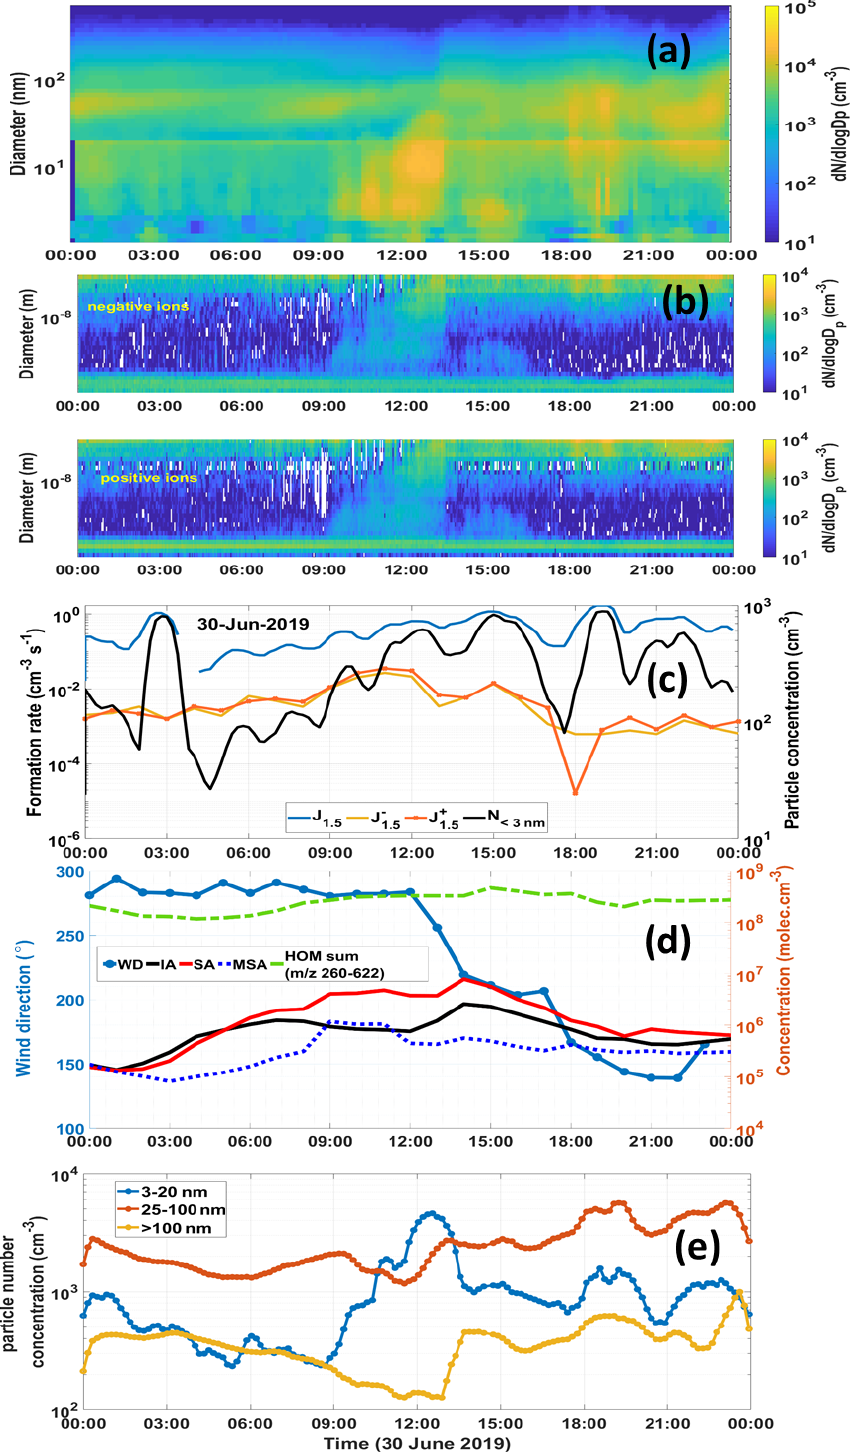
Figure 5. NPF event (regional and local events) on 30 June 2019. (a) Number size distribution of particles (data from the PSM, the NAIS and the DMPS; size range: sub-3–100nm). (b) Charged-particle number size distribution (negative: upper, positive: lower) obtained from the NAIS. (c) Diurnal variation in formation rates ( J 1 . 5 ) of 1.5nm particles and ions ( J − concentrations (1.5–3nm) on the right axis. (d) Diurnal variation in HOMs, SA, IA and MSA with wind direction (WD). (e) The diurnal variation in particle concentration in nucleation (3–20nm), Aitken (25–100nm) and accumulation mode ( > 100nm) particles during the event (data from the